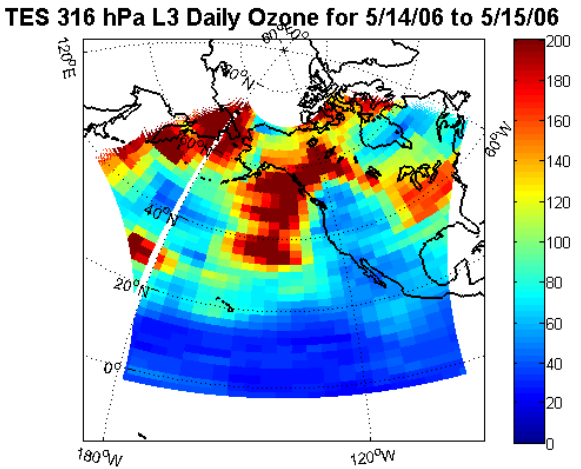
Fig. 1. TES Level 3 Daily Ozone plot for 14–15 May 2006 at 316hPa. Images such as this are an example of what is cur- rently available in terms of quick-view map products of UT ozone from